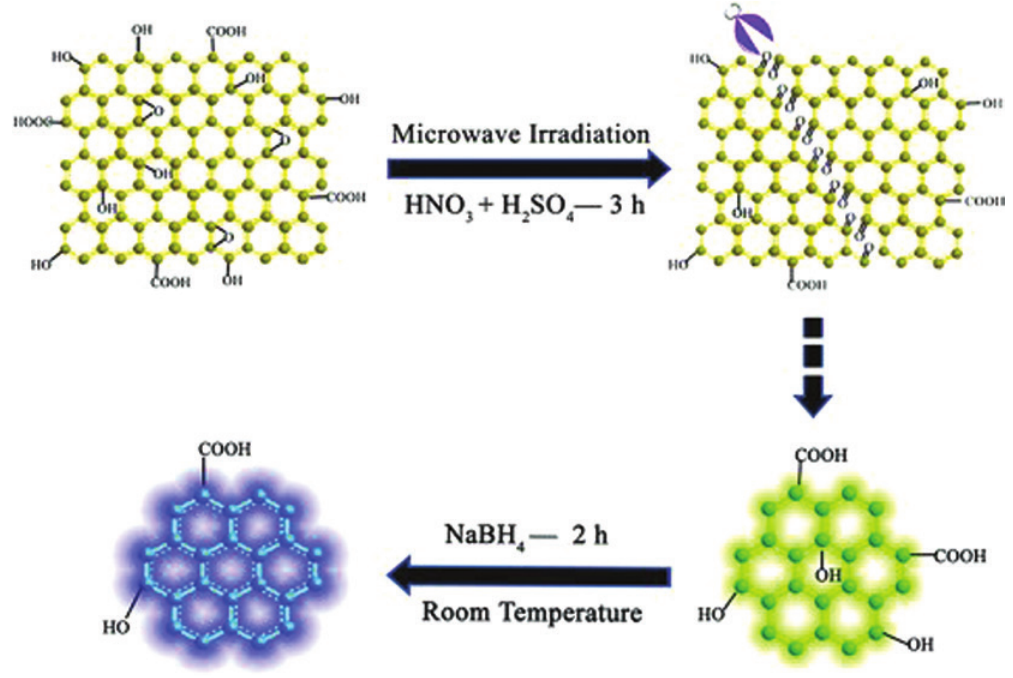
Figure 8: Schematic representation of the preparation route for gGQDs and bGQDs (reprinted/reproduced with the permission of Ref. [38], copyright 2012, Wiley-VCH Verlag GmbH &